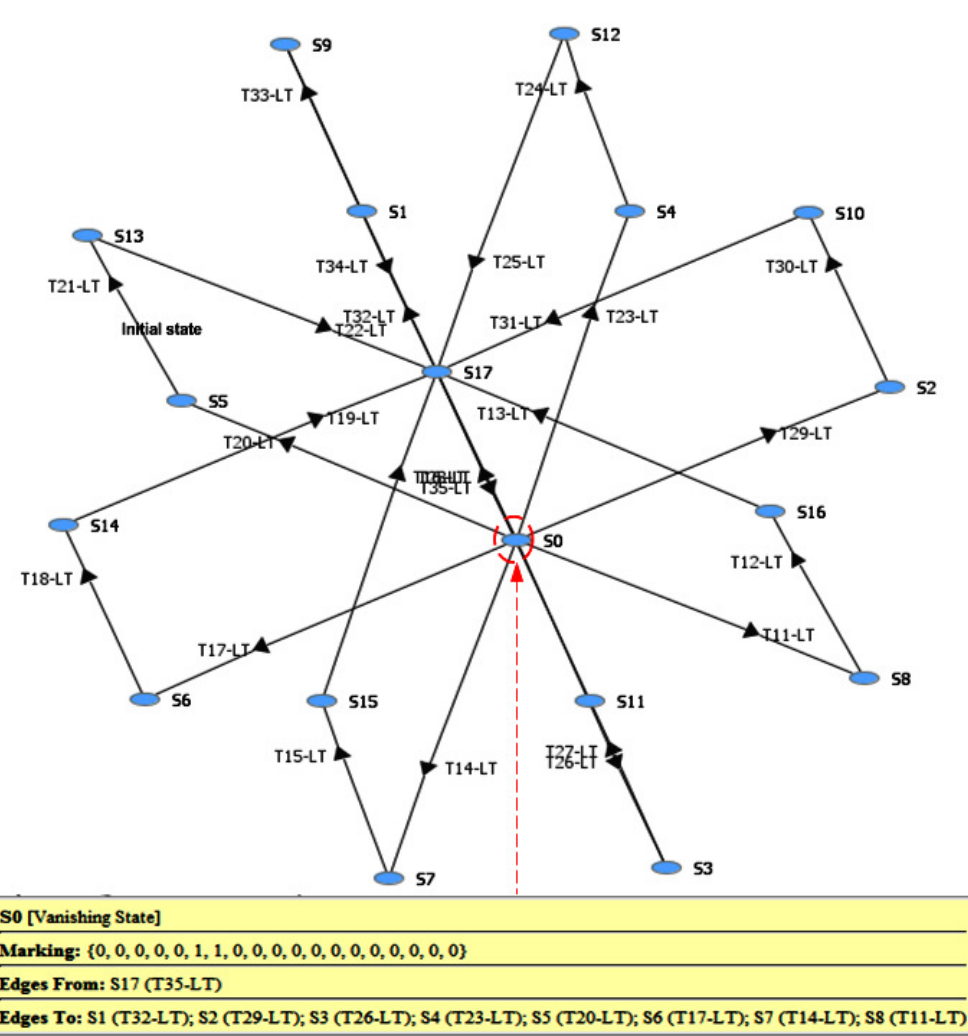
Figure 11. Reachability graph of the Load Transference